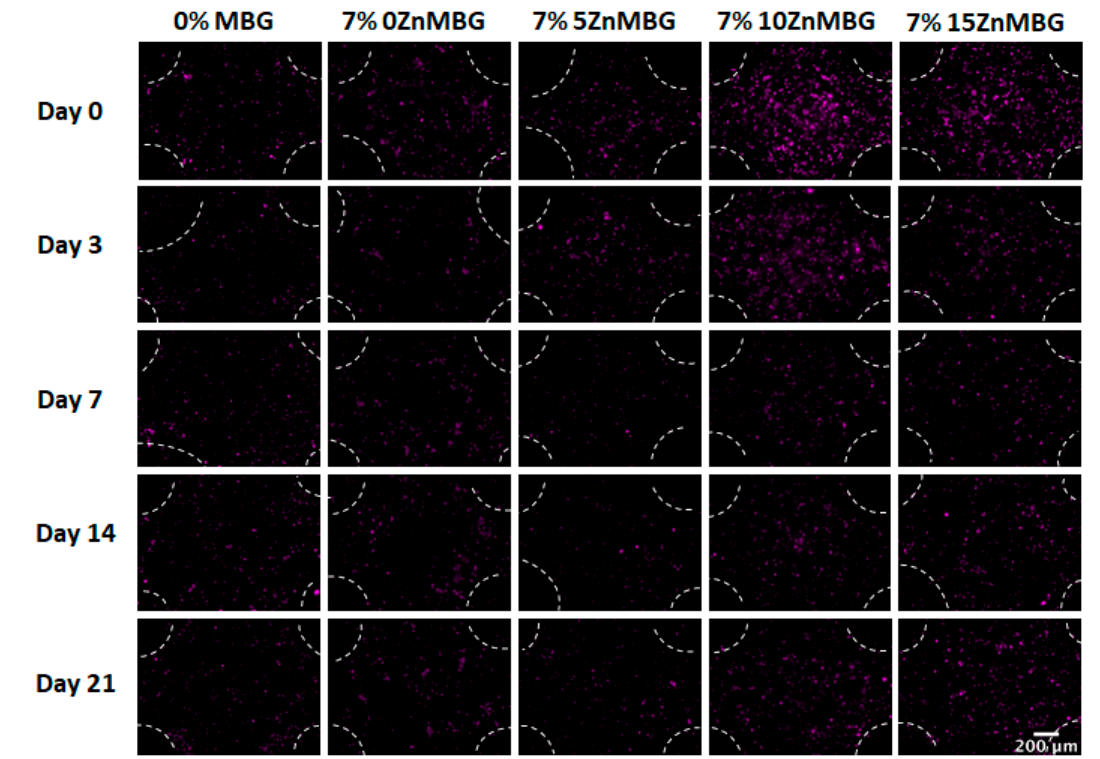
Figure 6. Fluorescence-microscopic images of Vibrant DiD pre-labeled MSC within bioprinted 3–9 composite scaffolds containing 7% of each ZnMBG and 3–9 algMC blend (0% MBG) during 21 days of culture. All images are taken at crossings of printed strands. White markings show the borders of printed strands and pores. Scale bar represents 200 µm and the cells appear as violet spots.